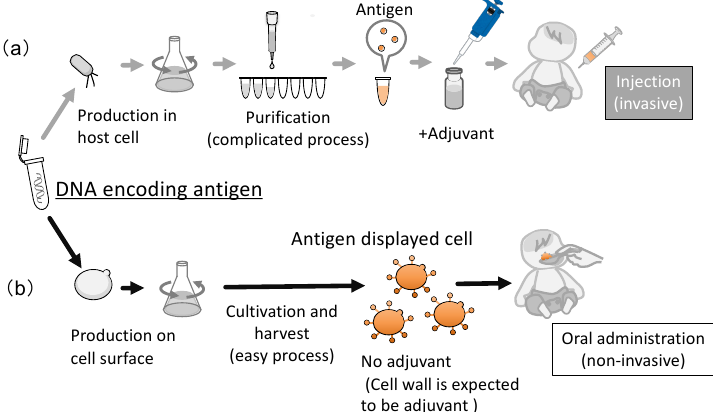
Figure 7. Overview of production of a vaccine by conventional method and molecular display. ( a ) Conventional recombinant vaccine (invasive administration), ( b ) Oral vaccine produced by molecular display using yeast cell (noninvasive administration). The figure was adapted from [126,129]. Animal vaccines have also been gaining importance. Recently, fish vaccines have seen increasing use in aquaculture, raising the need for convenient administration meth-